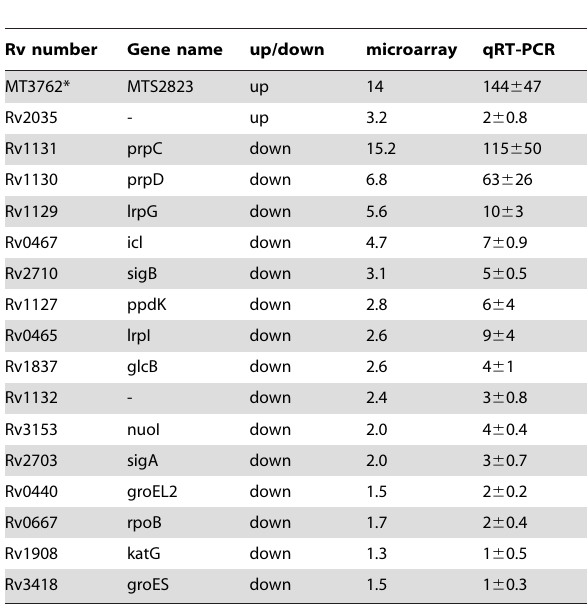
Table 11. Expression of selected genes upon over-expression of MTS2823.